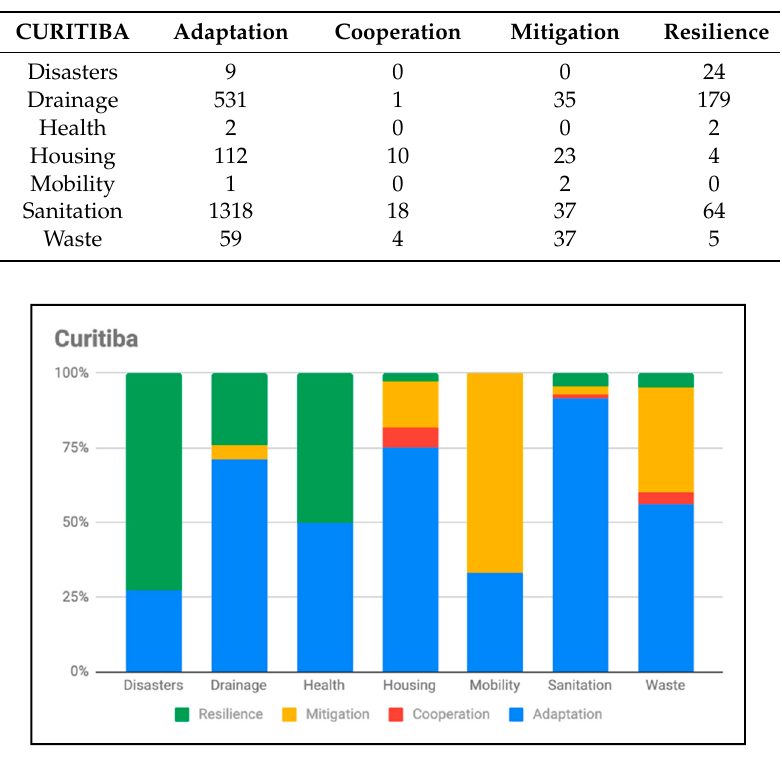
Table 9. Climate action references in Curitiba’s sectoral plans.